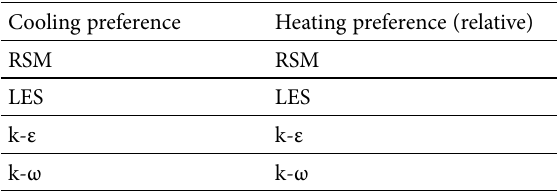
Table 3. The accuracy of the turbulence models regarding computations for cooling and heating capabilities